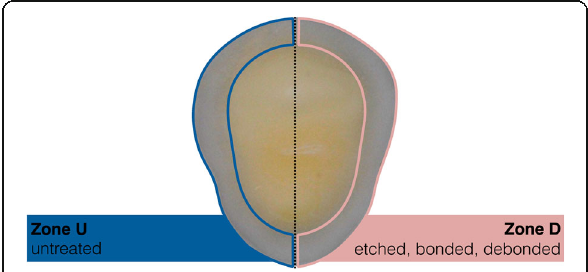
Fig. 1 Schematic drawing of the specimens prepared. The Zone U (untreated) and the Zone D (etched, bonded, debonded) are easily distinguished by the vertical